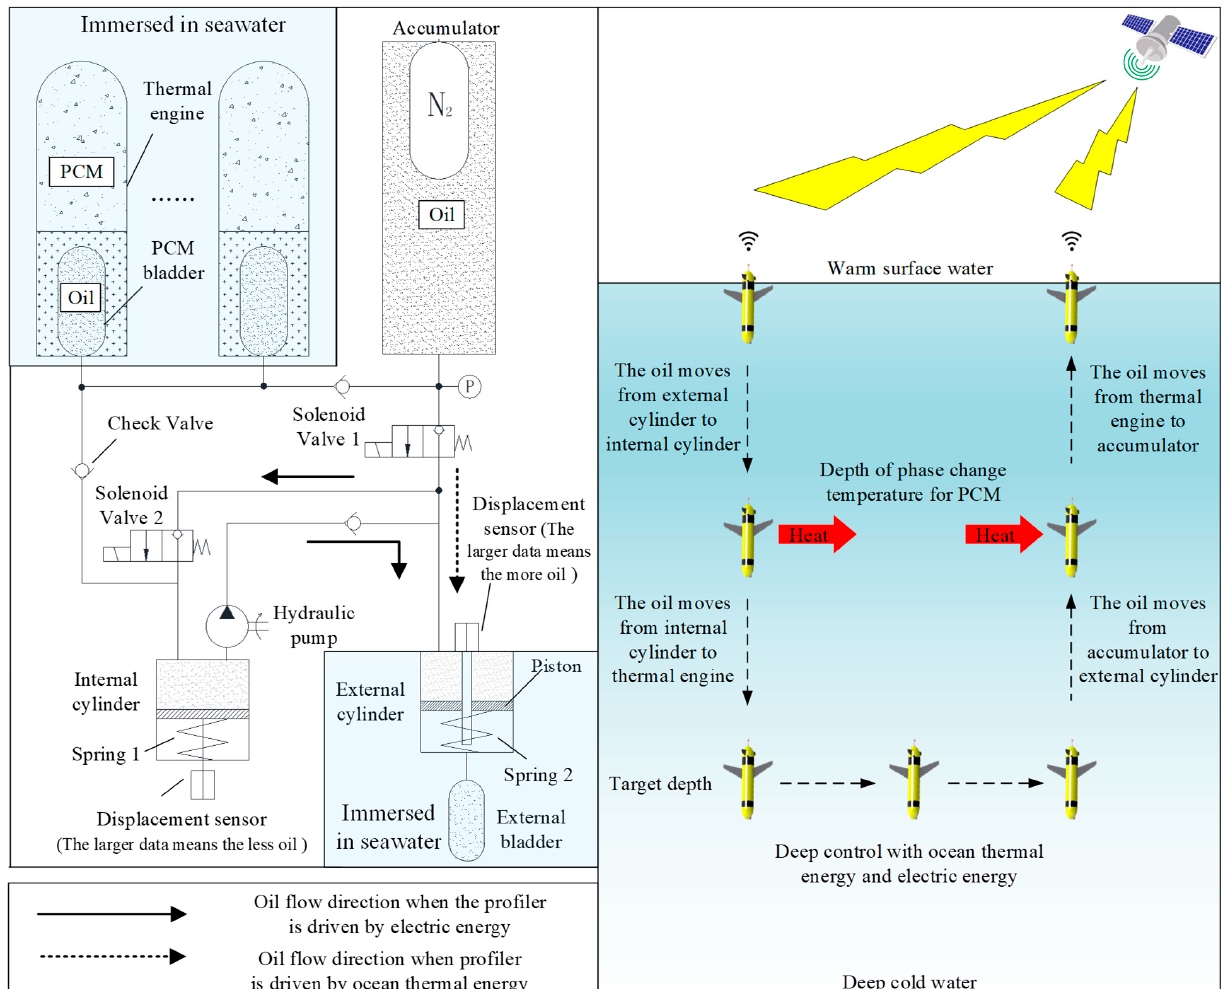
Figure 1. Principle diagram of the buoyancy adjustment system and the movement process.